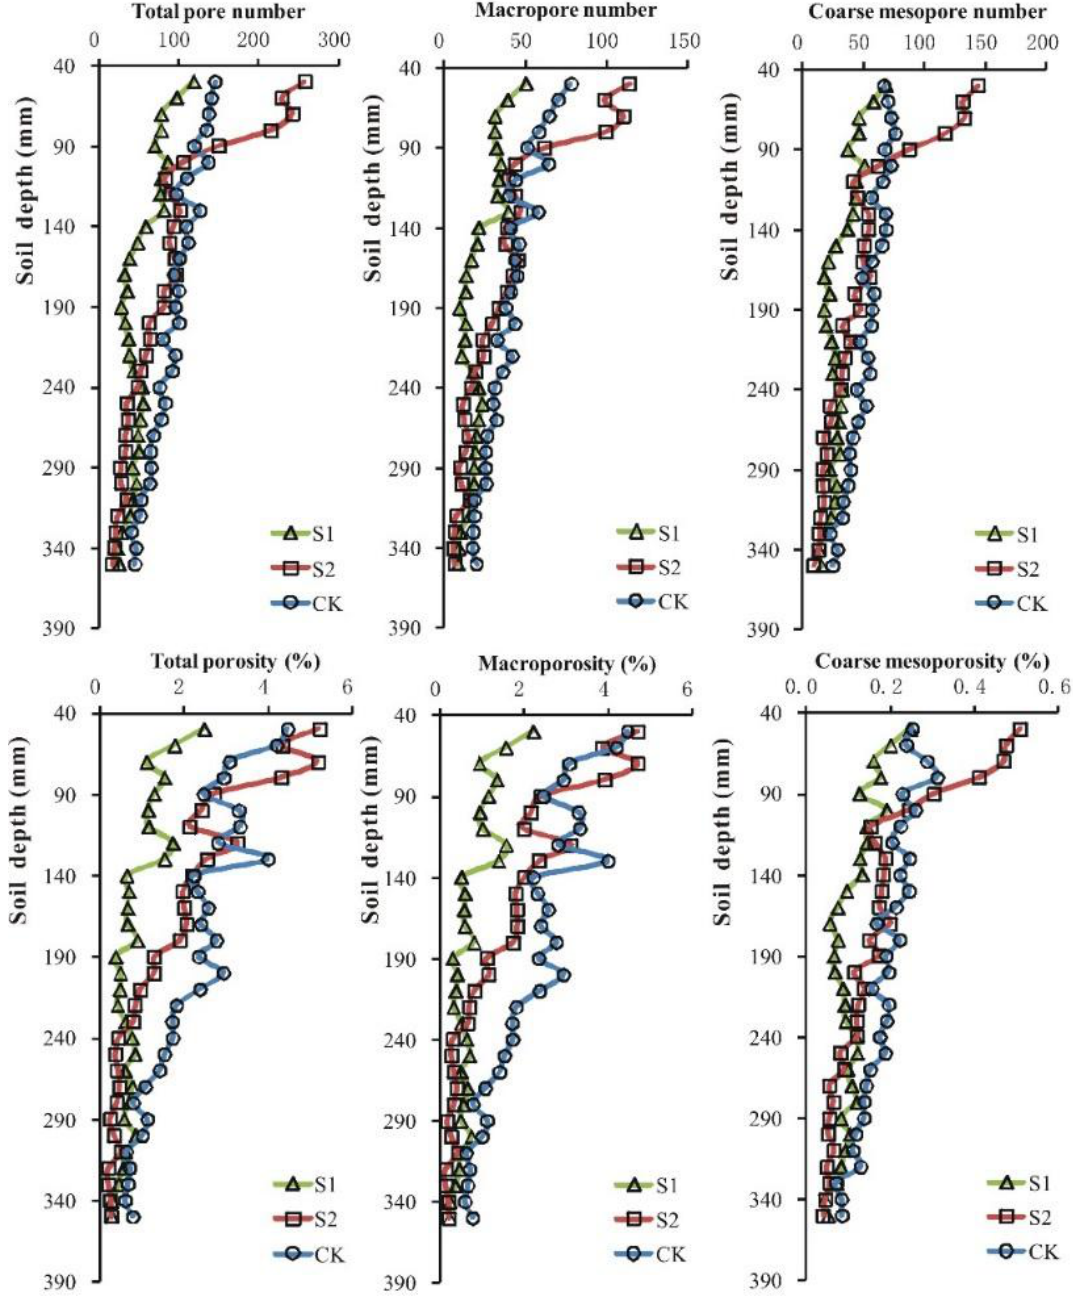
Figure 3. Distribution of total pore number, macropore number, coarse mesopore number, total porosity, macroporosity, and coarse mesoporosity at every 1-cm interval of the 5–35 cm depth from S1 (irrigated with sewage for 25 years, 3 replicates), S2 (irrigated with sewage for 52 years, 3 replicates), and CK (irrigated with groundwater, 3 replicates).